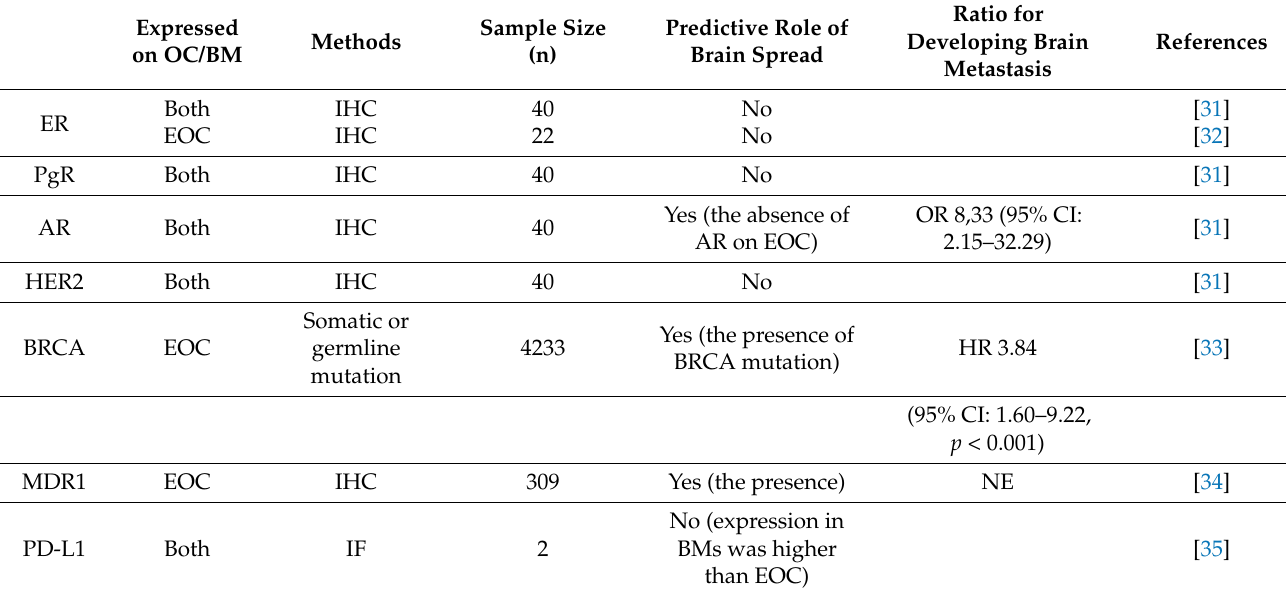
Table 1. Principle biomarkers of brain spread from